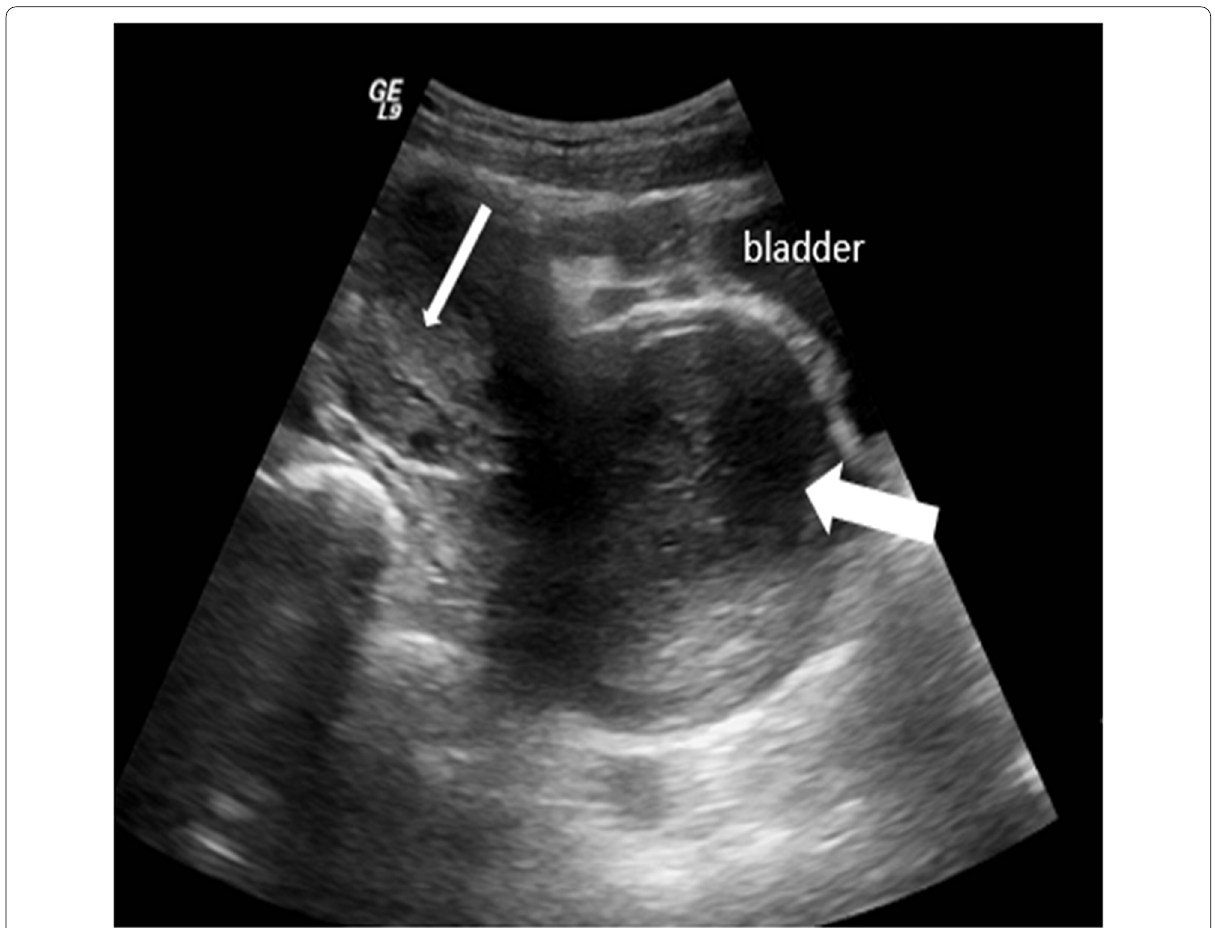
Fig. 1 Ultrasound at first presentation of the patient showing right hematocolpous of obstructed right hemi-vagina (thick arrow) with an empty cavity of the right hemi-uterus (thin arrow) after drainage of the hematometra in another hospital